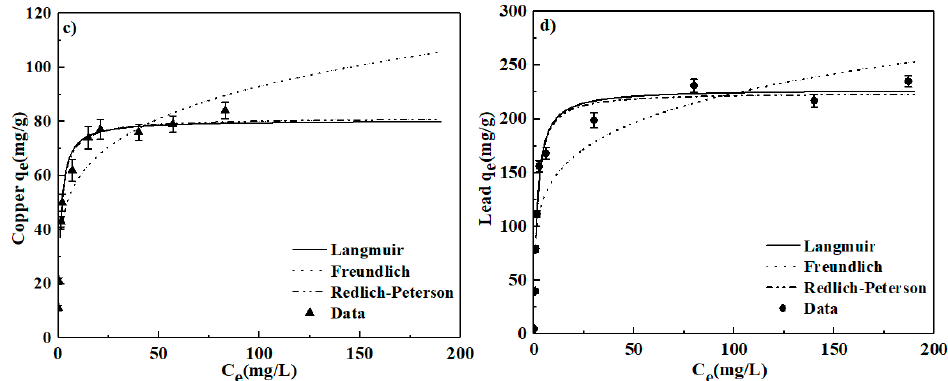
Figure 7. Kinetic ( a , b ) and isotherm ( c , d ) of Cu(II) and Pb(II) sorption on CLB at 25 ± 1 °C without pH modification. About kinetic experiments, samples were withdrawn at different time (0.05, 0.25, 0.75, 3, 6, 12, 24, 36, 48 h). ( a ): 0.25 g CLB was added into 100 mL solution containing 200 mg/L Cu(II); ( b ): 0.25 g CLB was added into 100 mL solution containing 600 mg/L Pb(II); As for isotherm experiments, samples were withdrawn after shaking 24 h. ( c ): 0.25 g CLB was added into 100 mL solution containing 30, 60, 90, 120, 150, 180, 210, 240, 270, 300 mg / L Cu(II), respectively. ( d ): 0.25 g CLB was added into 100 mL